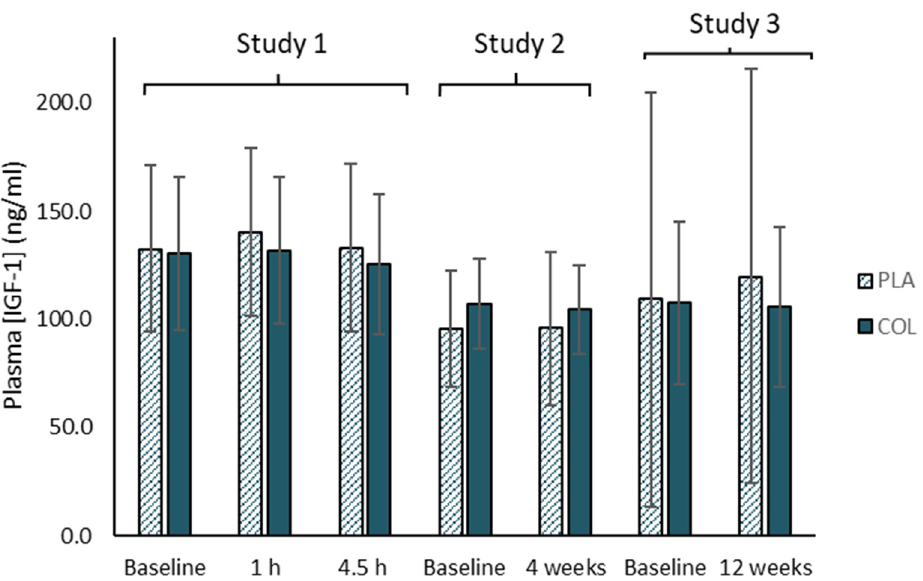
Figure 3. Summary of results from Davison et al. [76] showing no effects of acute (1–4.5 h post-ingestion: study 1) and chronic daily (4 weeks: Study 2; and 12 weeks: Study 3) bovine colostrum supplementation on IGF-1 levels.